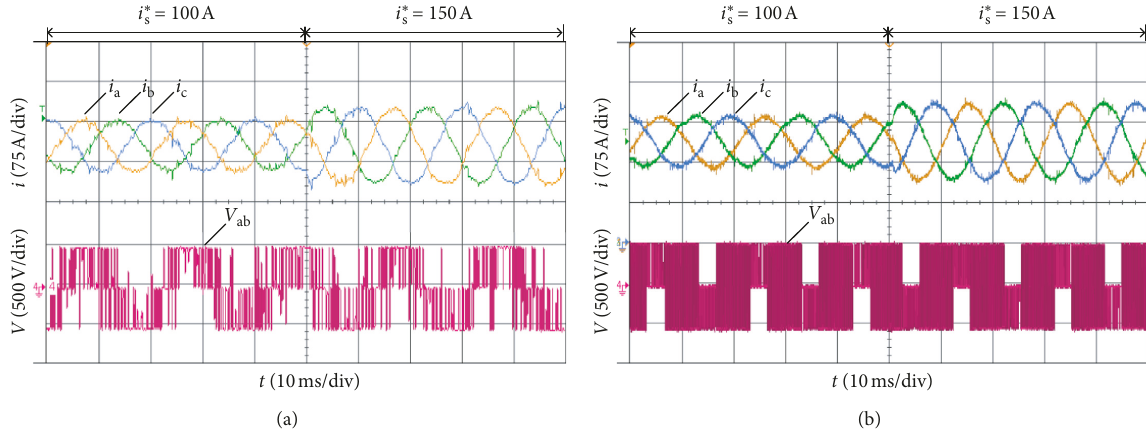
Figure 14: Three-phase current and line-to-line voltage curves. (a) The conventional MPC-RCMV. (b) The proposed MPC-RCMV with constant switching frequency.